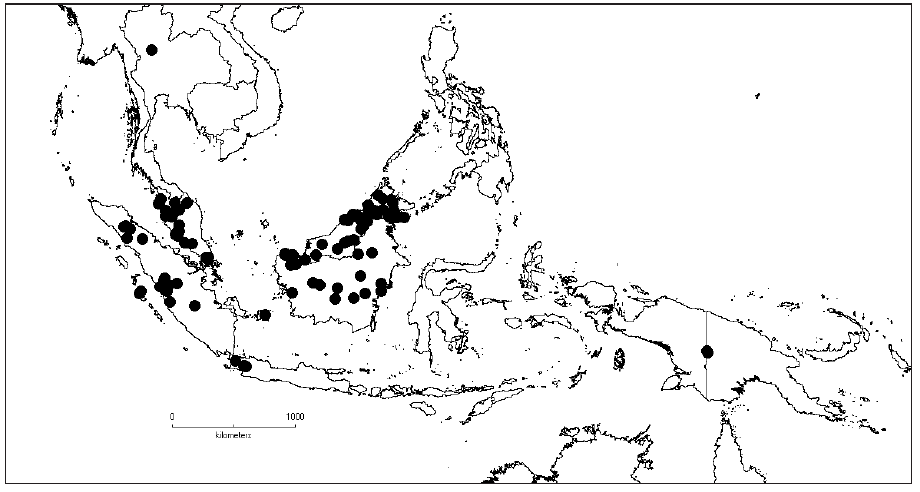
Map 28. Distribution of D. viminalis ( ●